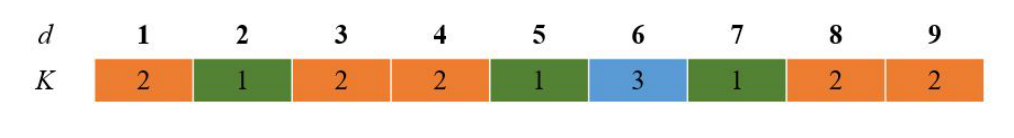
Figure 2. Solution representation of the clustering